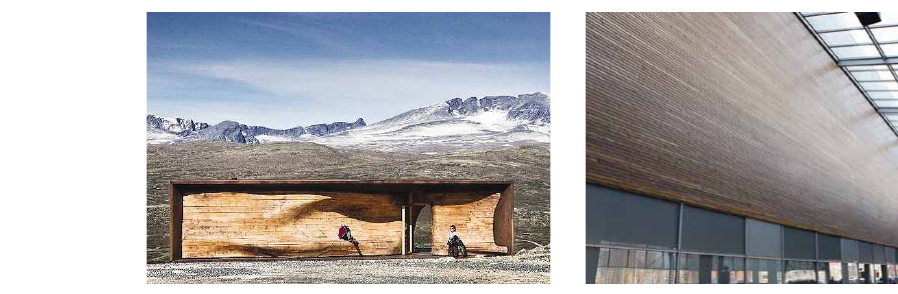
Fig. 2. Shopping and entertainment center “Akropolis”, Klaipėda, archit. office “Gedimino Jurevičiaus studija”,